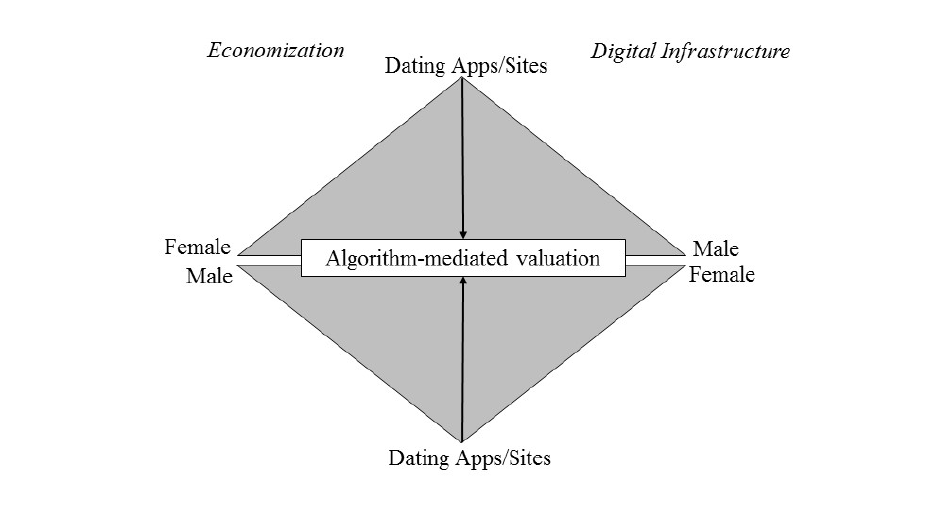
Figure 5 Heterosexual intimate valuation online Source: Authors’